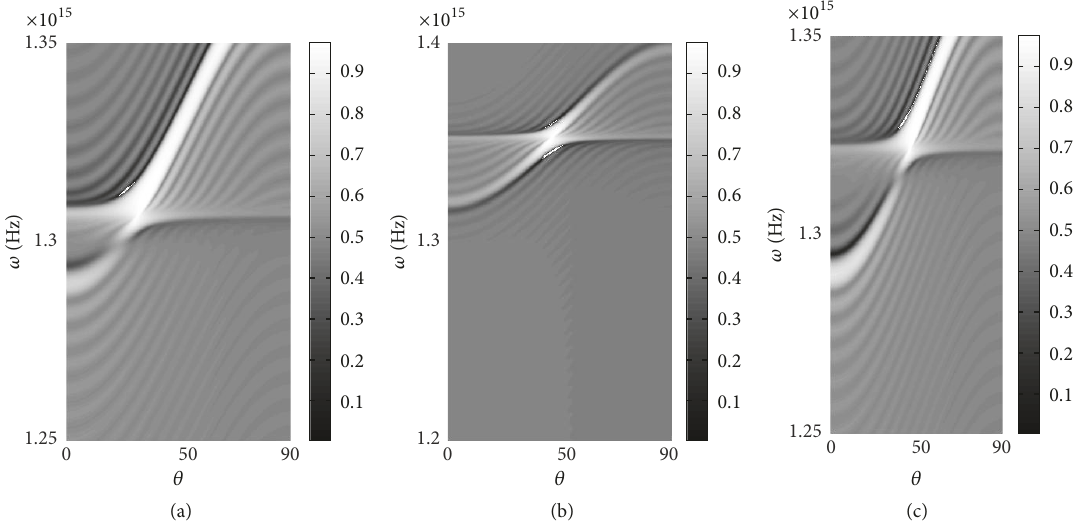
Figure 5: Black areas are band-gaps of photonic crystals containing 200-periodic (a) InGaAs/InP, (b) InGaAs/GaAs, and (c) InAlAs/InP QWs with implementing an external pump pulse.